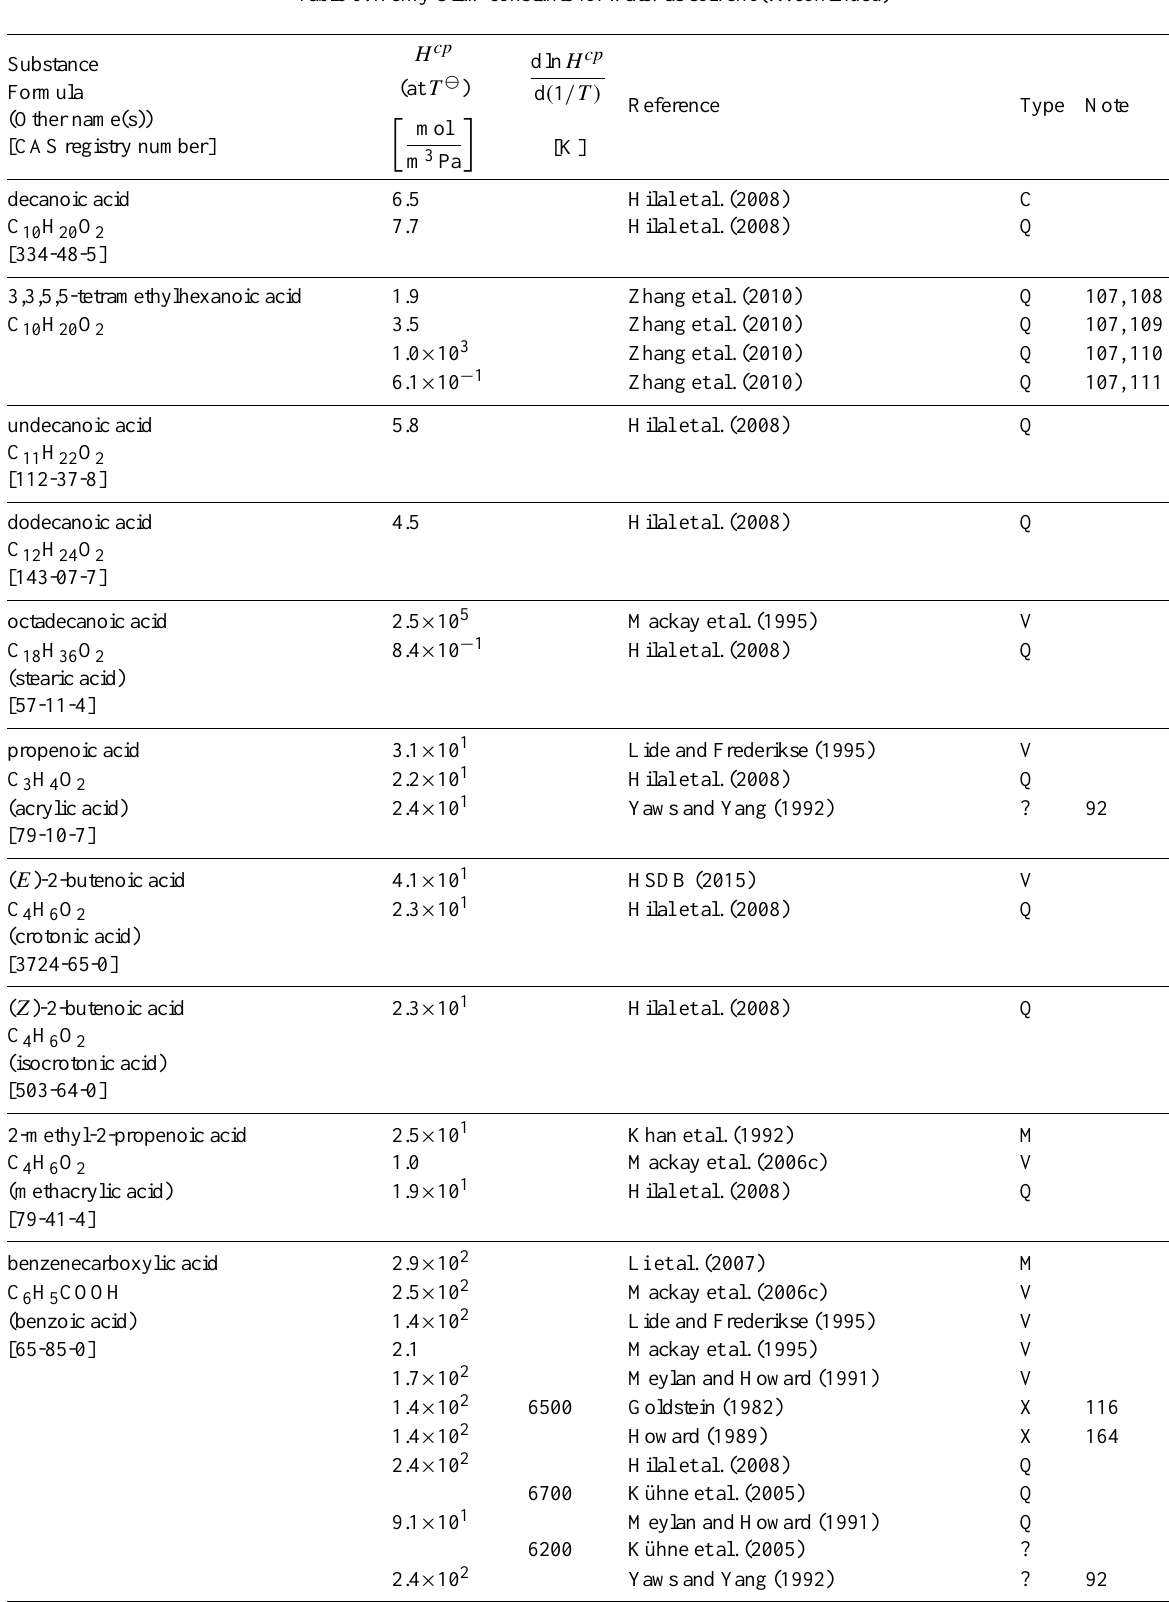
Table 6: Henry’s law constants for water as solvent